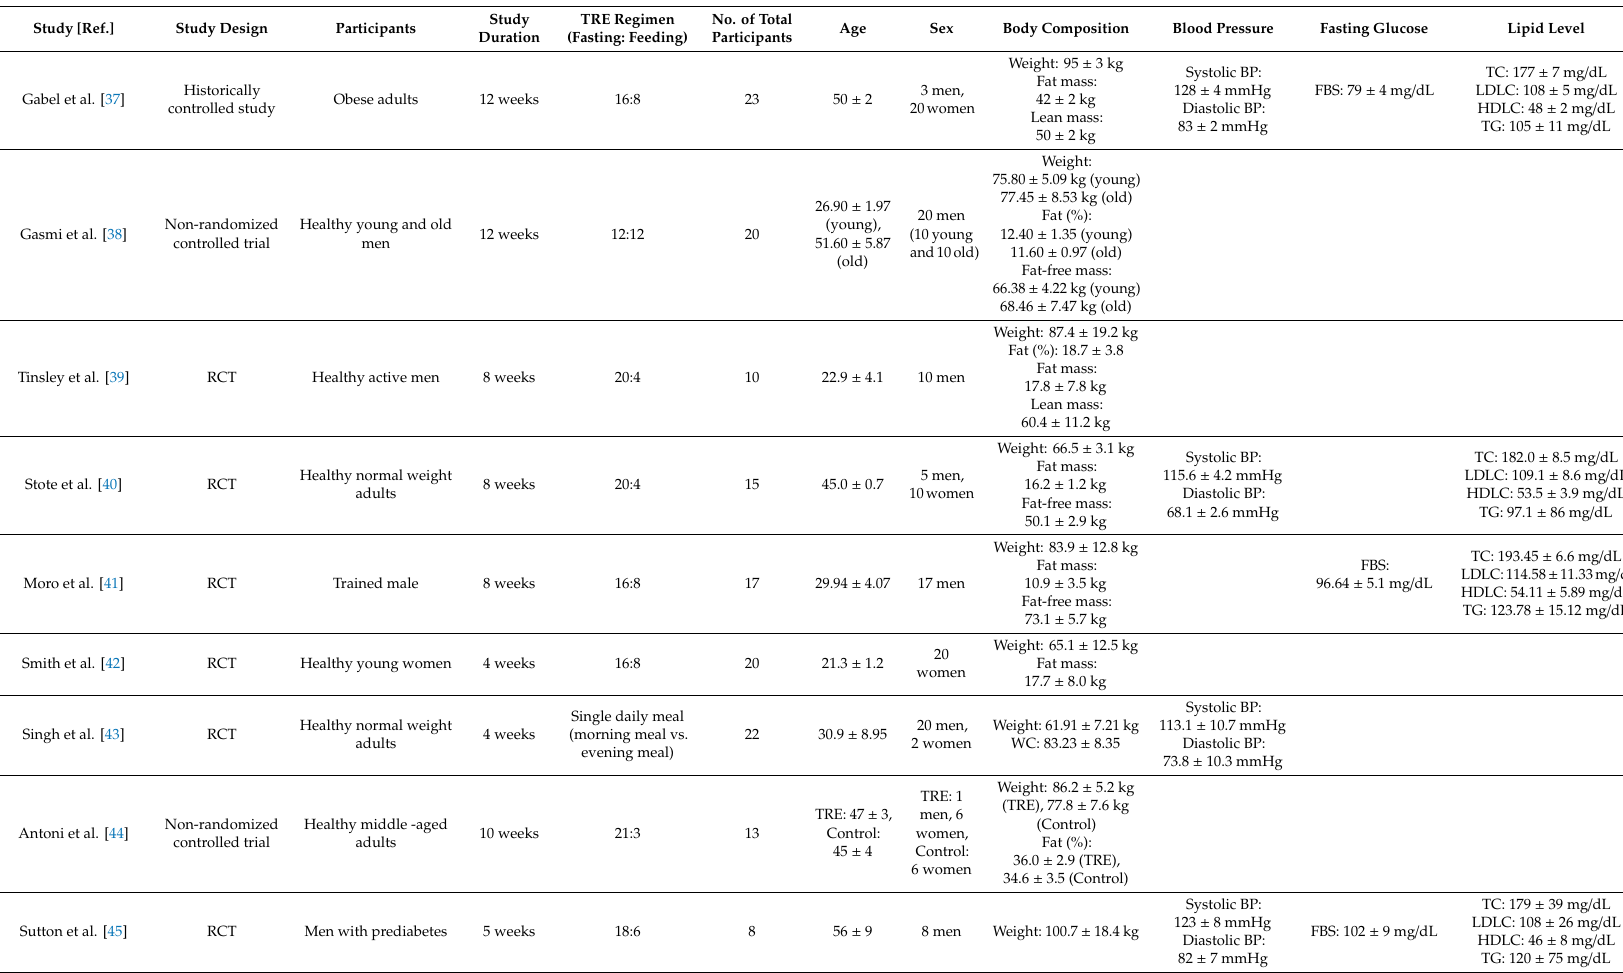
Obeseadults 12weeks 16:8 23 50 ± 2 3men, 20women